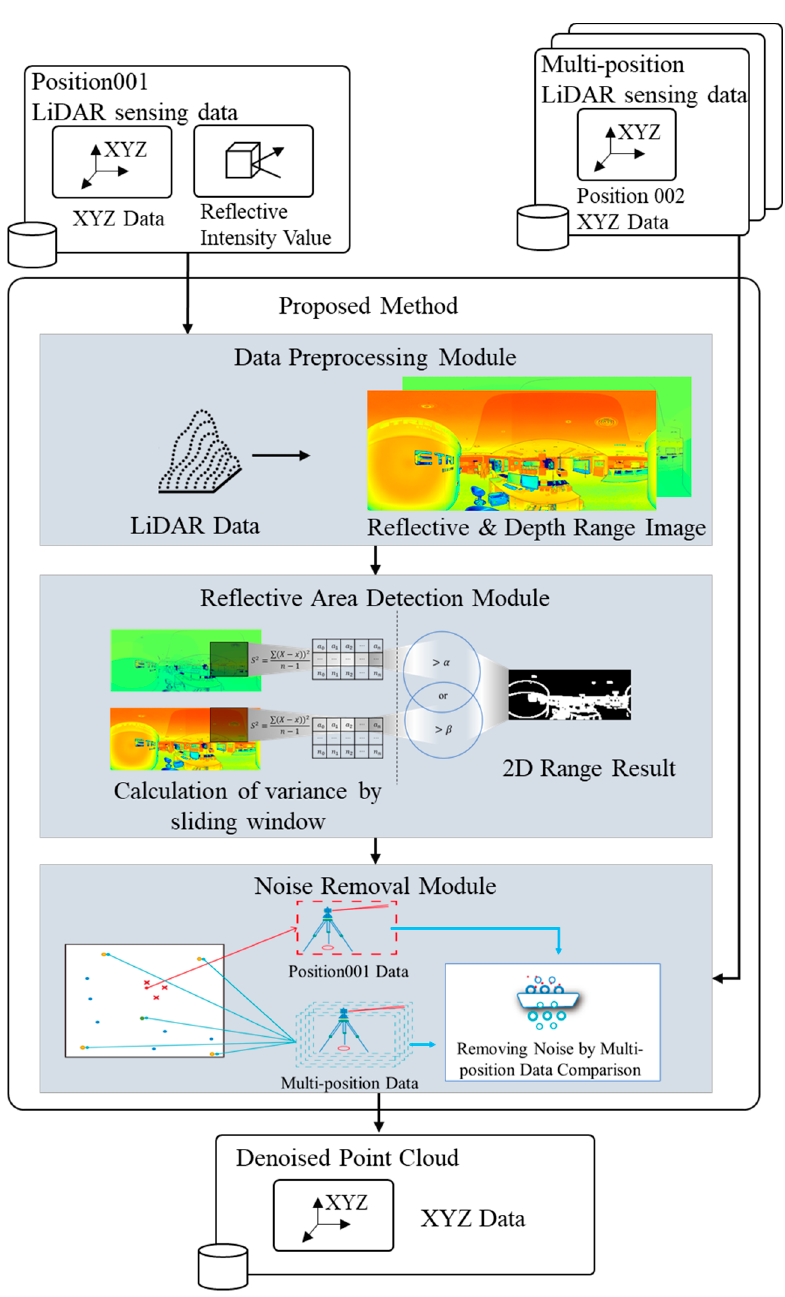
Figure 3. Overview of the proposed